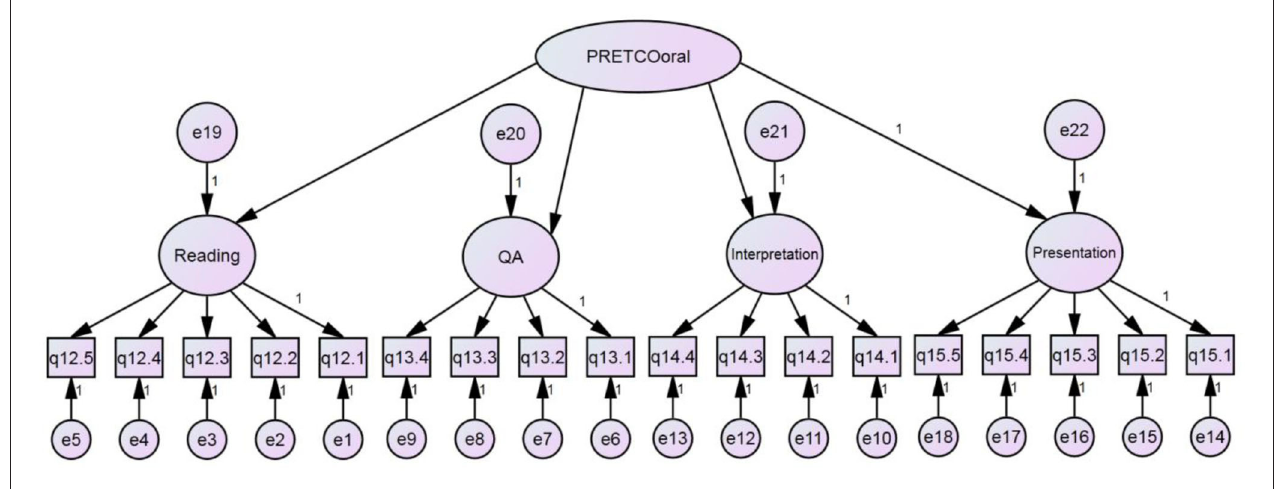
FIGURE 3 | Hypothetical model 2 of PRETCO-oral. TABLE 1 | Rater mean-square infit